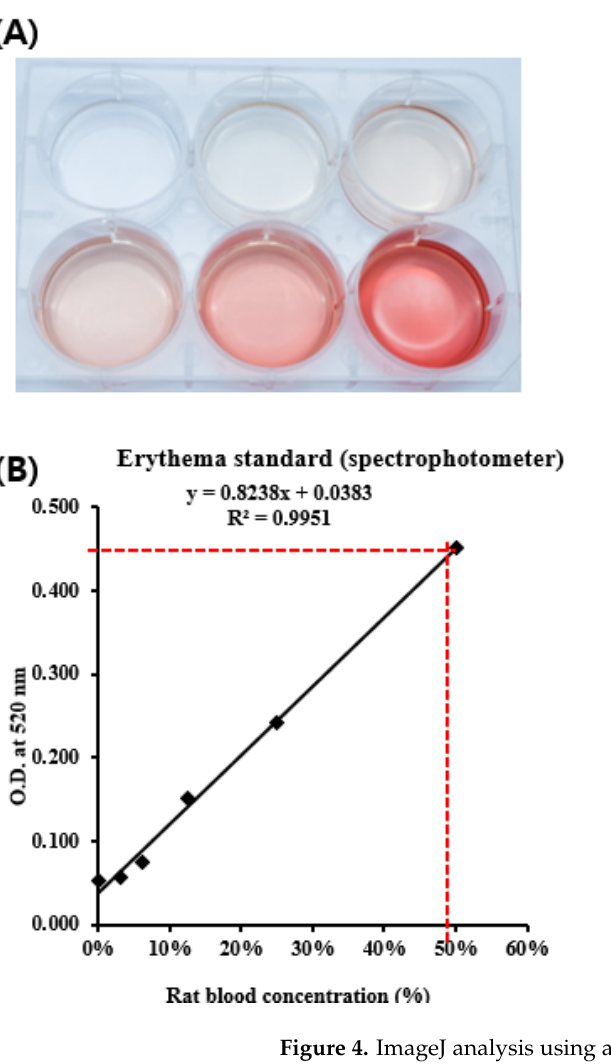
Figure 4. ImageJ analysis using a phased erythema standard. ( A ) Photograph of diluted blood on 6- well plate. The blood was collected from a mouse, and the blood concentrations were 0%, 3.125%, 6.25%, 12.5%, 25%, and 50%. The erythema standard was calculated by spectrophotometer ( B ) and ImageJ analysis ( C ). The erythema range on the photograph was adjusted as a blood.